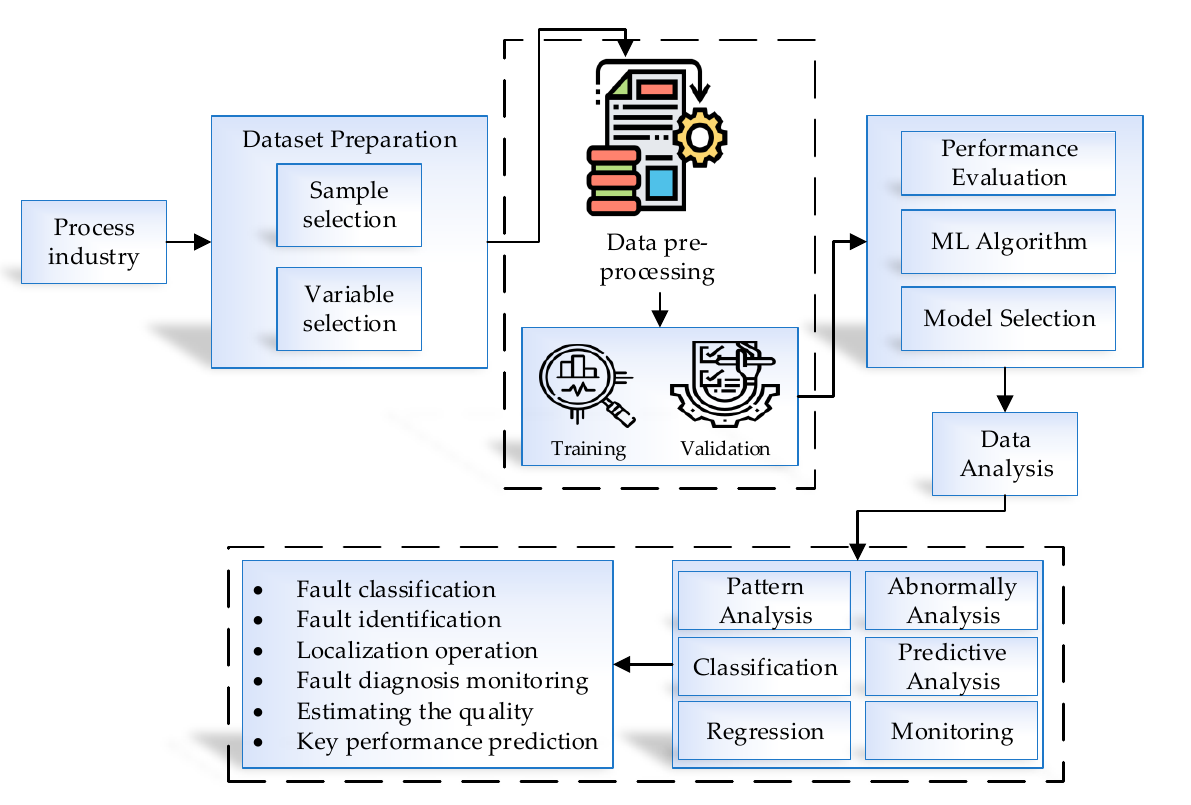
Figure 7. Machine learning fault detection process.